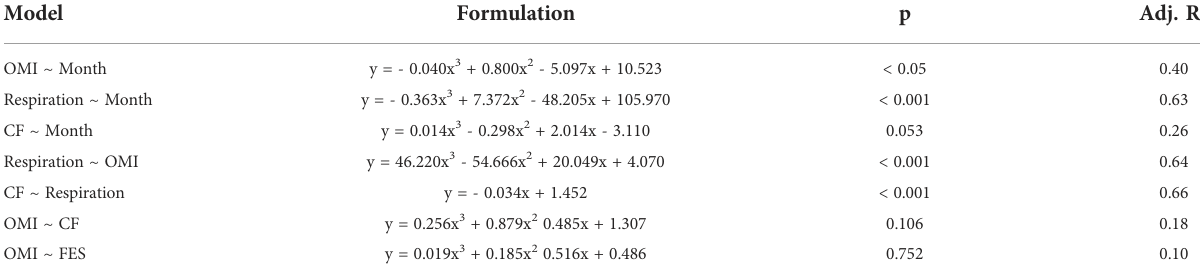
TABLE 3 Model formulations, p-values and adjusted R-squared values (Adj. R 2 ) for the regressions used to determine the relationships between the onset of maturity index (OMI), respiration rate (mg C ind -1 day -1 ), and condition factor (CF; WWT (mg) mm -3.44